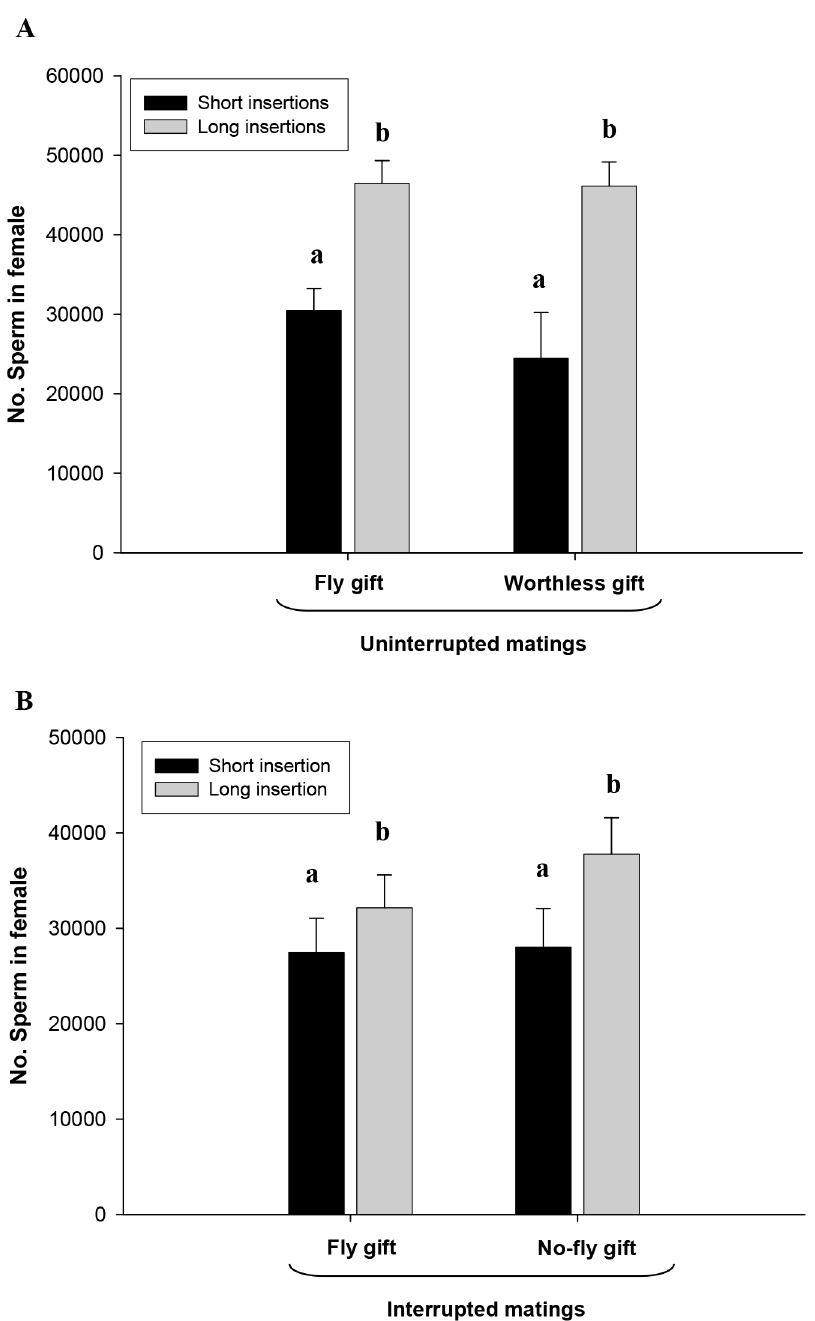
Fig 4. Number of sperm in female spermathecae resulting from long insertions and short insertions in A) uninterrupted matings: Fly gift-uninterrupted mating, males offering a fly gift and Worthless gift- uninterrupted mating, males offering a worthless gift; B) interrupted matings: Fly gift-interrupted mating, males offering a fly gift and performing one pedipalp insertion, No-fly gift-interrupted mating, males offering no gift and performing one pedipalp insertion. Data are shown as Means ± SE; different letters indicate significant differences (p < 0.05; Table